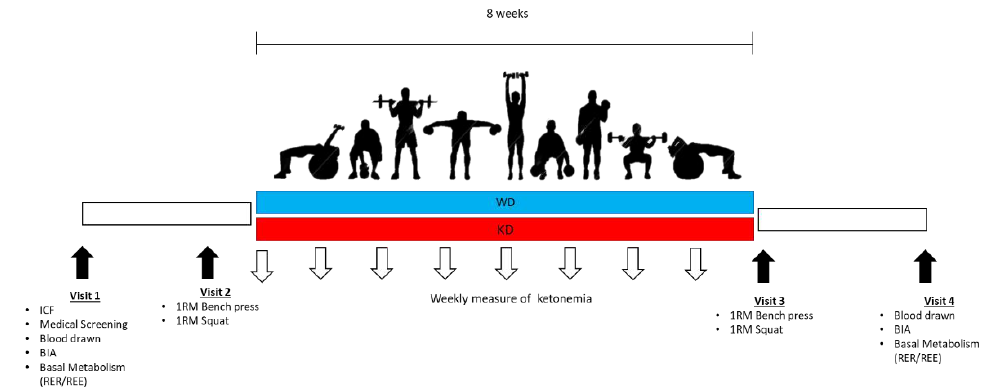
Figure 1. Study design. ICF, Informed consent form signed; BIA, Bioelectrical Impendence Analysis; REE, Basal metabolism; RER, respiratory quotient; 1 RM, 1 repetition-maximum test; WD, Western diet, KD, Ketogenic Diet.